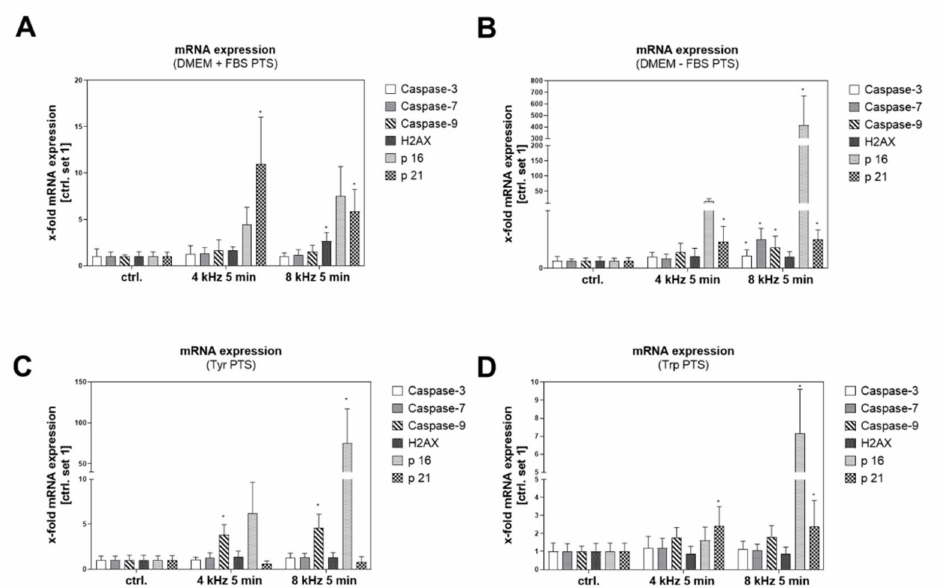
Figure 7. Expression of apoptosis- and senescence-associated genes in Mel Im cells after PTS treat- ment. The x-fold mRNA expression of Caspase-3, -7, -9, H2AX, p16 and p21 in melanoma cells after 5-min treatment with 4 kHz and 8 kHz CAP solutions was analyzed in comparison to the untreated control (n = 3 in duplicated form). ( A ) DMEM + FBS PTS, ( B ) DMEM–FBS PTS, ( C ) Tyr PTS, ( D ) Trp PTS. Statistical analysis: Bonferroni’s multiple comparisons test. All of the significant results compared to the untreated control are indicated with * p ≤ 0.05. The significant results between the 4 kHz and 8 kHz CAP-treated samples are not